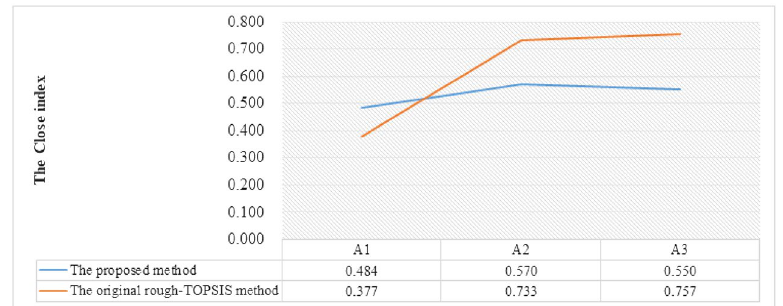
Figure 5. The comparison between the original rough-TOPSIS method and the proposed method.